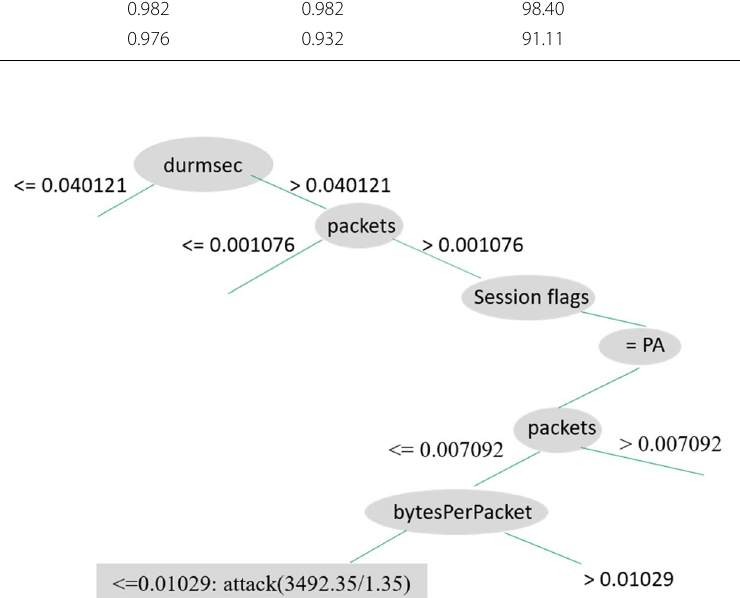
Fig. 5 Pre-normalized C4.5D tree